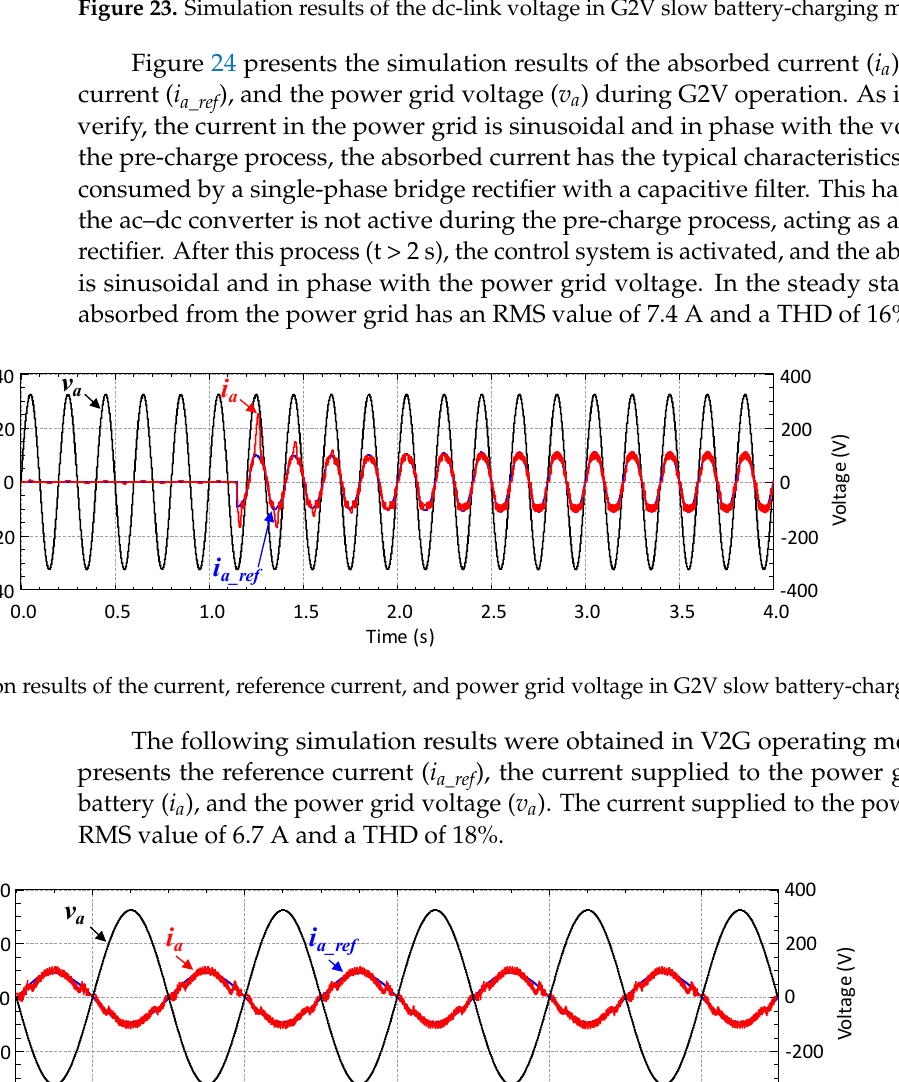
Figure 23. Simulation results of the dc-link voltage in G2V slow battery-charging mode.